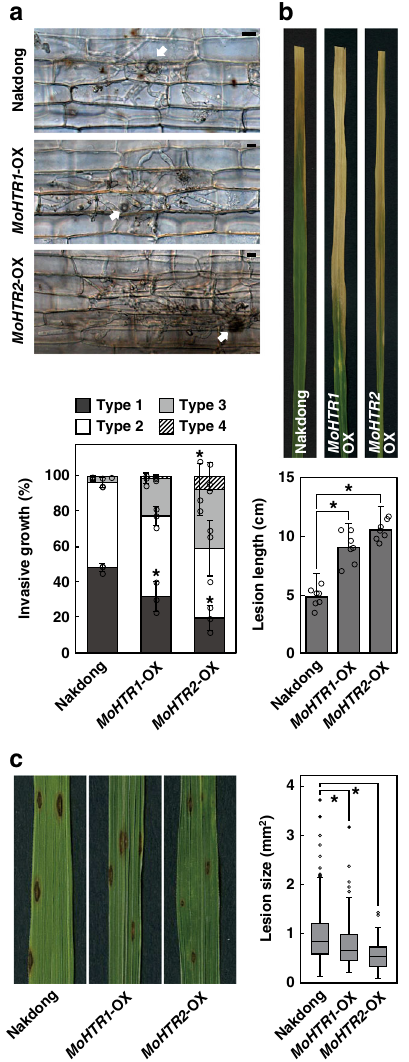
Fig. 6 Expression of MoHTR1 and MoHTR2 in rice affects disease susceptibility to multiple pathogens. a Invasive growth of KJ201 in sheath cells of Nakdong, MoHTR1 -OX, and MoHTR2 -OX at 48 hpi was observed under light microscopy and rated (from type 1 to type 4 as described in the Methods). The arrow indicates the appressorium on initially penetrated cells. Each bar represents the proportion of individual infection types. n = 3 independent experiments; mean±SD; * P <0.05, one-way ANOVA (in randomized block design) with Tukey ’ s HSD test. Scale bars = 10 μ m. b Representative disease symptoms caused by X . oryzae pv. oryzae ( Xoo ) at 7 dpi and lesion length. n = 7 independently inoculated plants; mean ± SD; * P <0.05, one-way ANOVA with Tukey ’ s HSD test. c Representative disease symptoms caused by C . miyabeanus at 7 dpi and lesion size distribution. n = 349 for Nakdong, n = 143 for MoHTR1 - OX, n = 95 for MoHTR2 -OX; * P <0.05, Kruskal-Wallis test with pairwise comparison. Boxes represent median, fi rst, and third quartile. Whiskers show the highest and lowest values that are within 1.5 interquartile range. Three independent experiments produced similar results, and data from one experiment are presented. Detailed information about biological repeat experiments and statistical analysis are provided as a Source Data fi